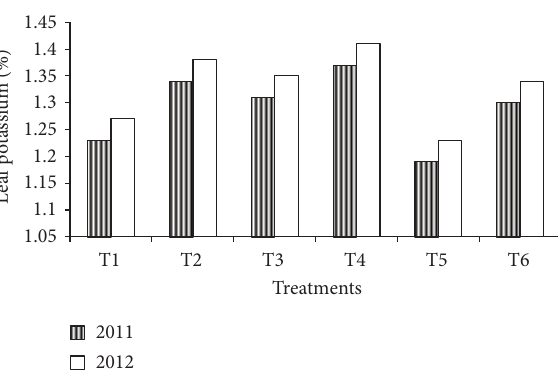
Figure 4: Leaf potassium as influenced by N&K fertigation in